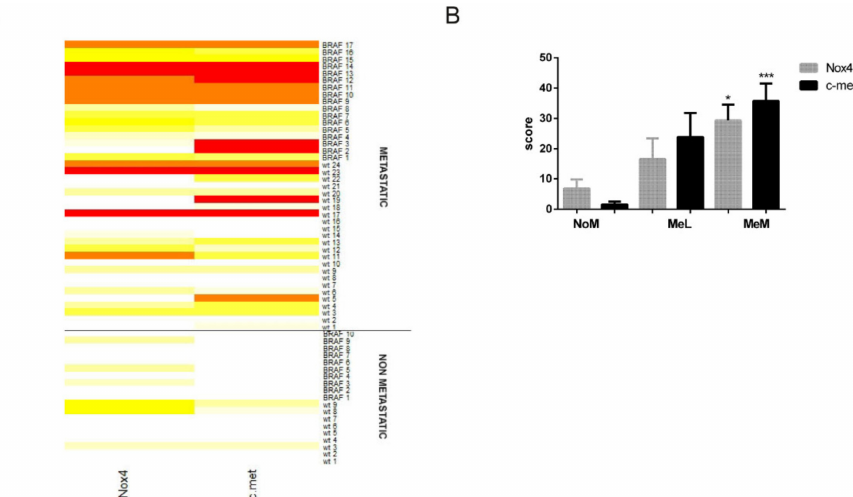
Figure 1. Nox4 and c-met expression in primary melanoma. ( A ) Heat-map showing the Nox4 and c-met IHC staining in primary melanoma, NoM and MeM, WT or with BRAF mutation. White means 0% of positive cells, intense red means 100%, yellow and orange mean levels in between. ( B ) Graph showing immunohistochemical (IHC) evaluation, dividing metastatic melanoma in MeL (positivity only in lymph nodes) and MeM (distant metastasis). * p- value < 0.05; *** p- value <